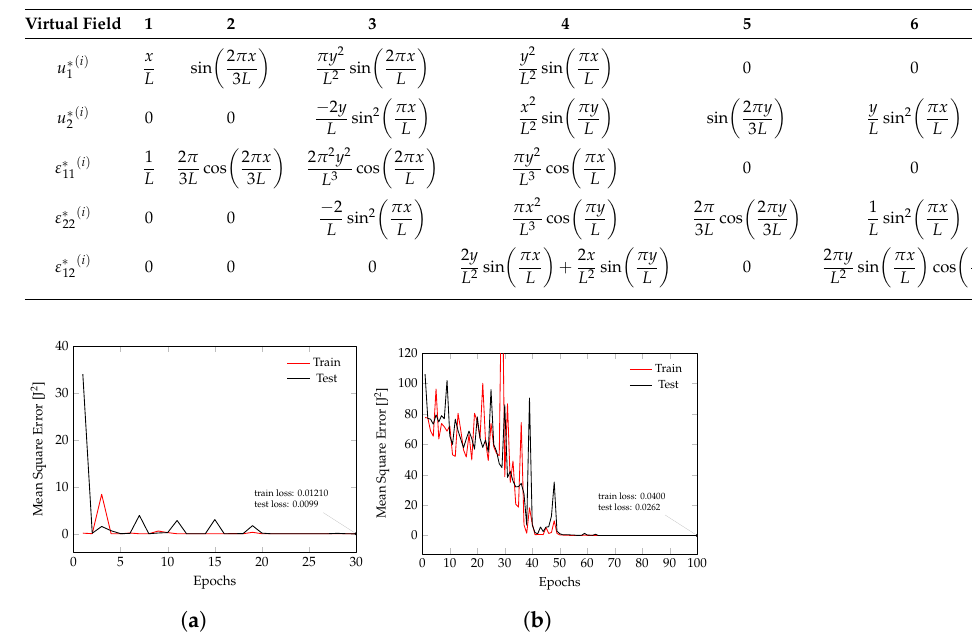
Table 9. Virtual fields used to train both ANN models. Virtual fields 1 through 4 were used to train the elastic model, while the whole set was used to trained the elastoplastic model.